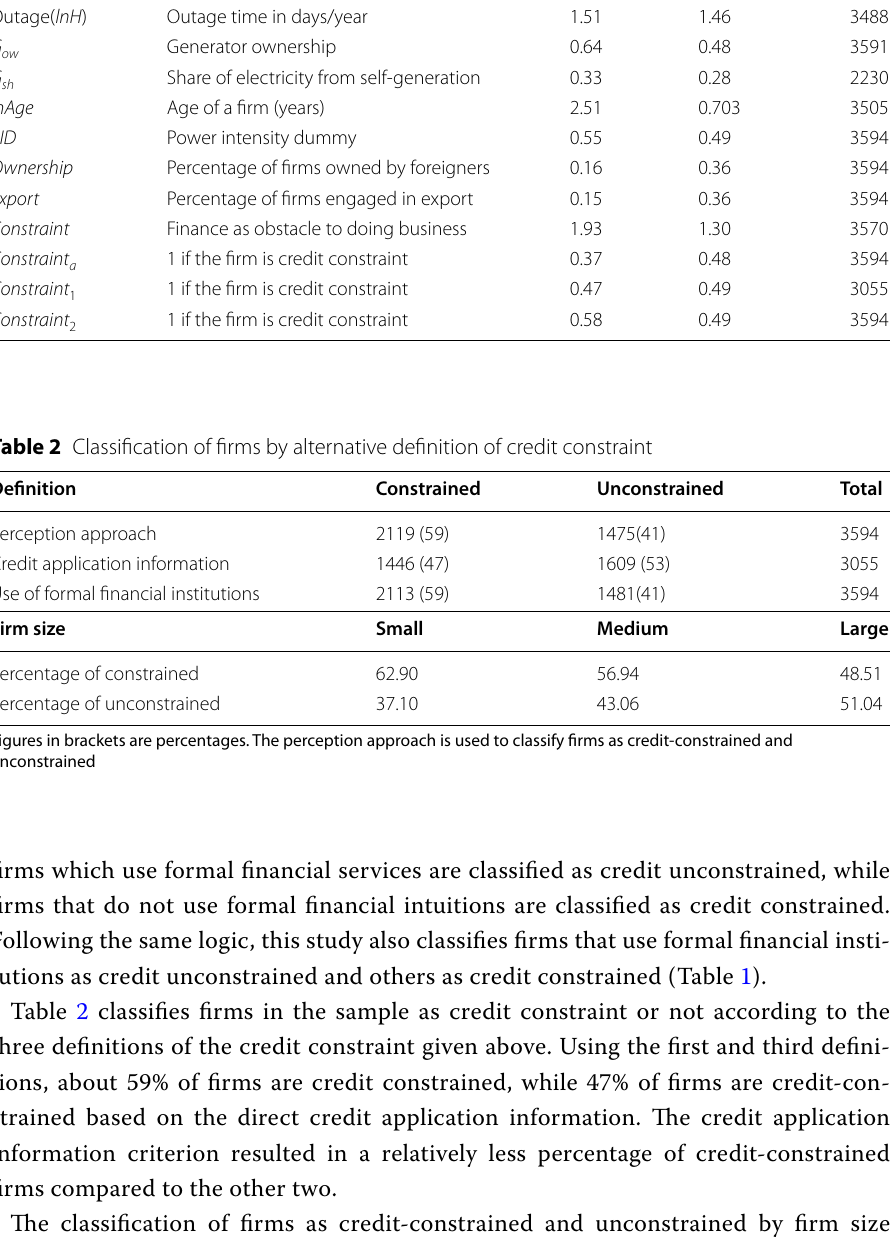
Table 1 Description and definition of variables Variable